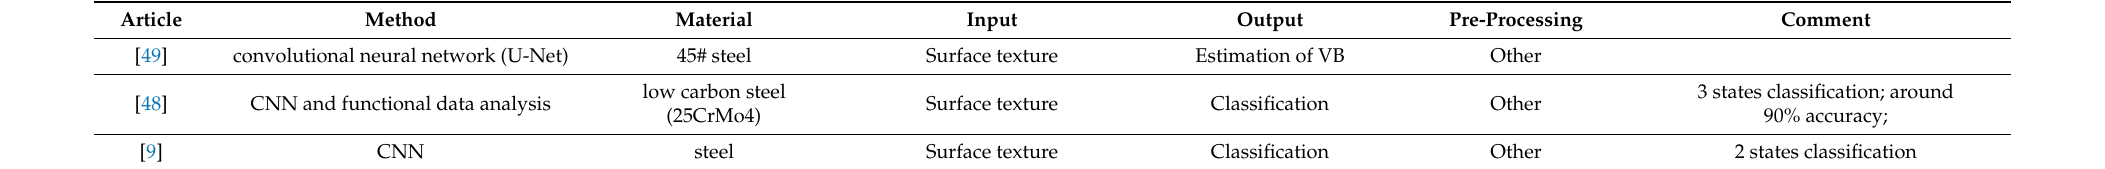
Table A7. General summary of CNN-related publications.